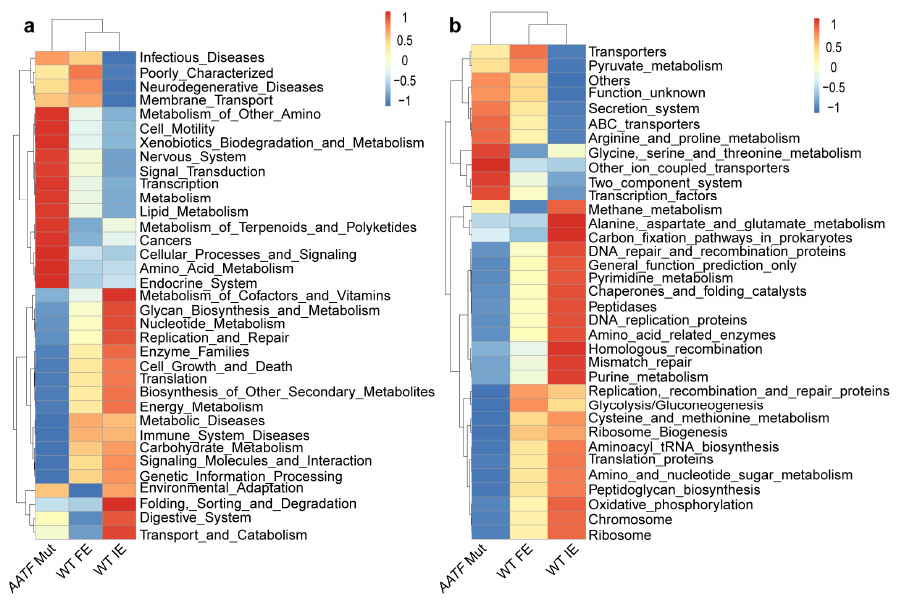
Figure 6. The differences in metabolic pathways by PICRUSt functional analysis. Related KEGG pathways are plotted at KEGG level 2 ( a ), and KEGG level 3 ( b ) between three groups. Mut, mutation; WT, wild-type.